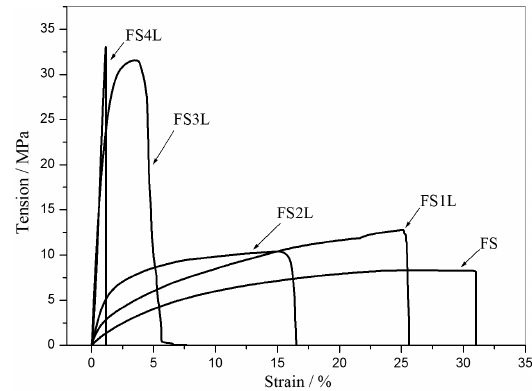
Figure 4. Illustration of the tension × strain behavior of the